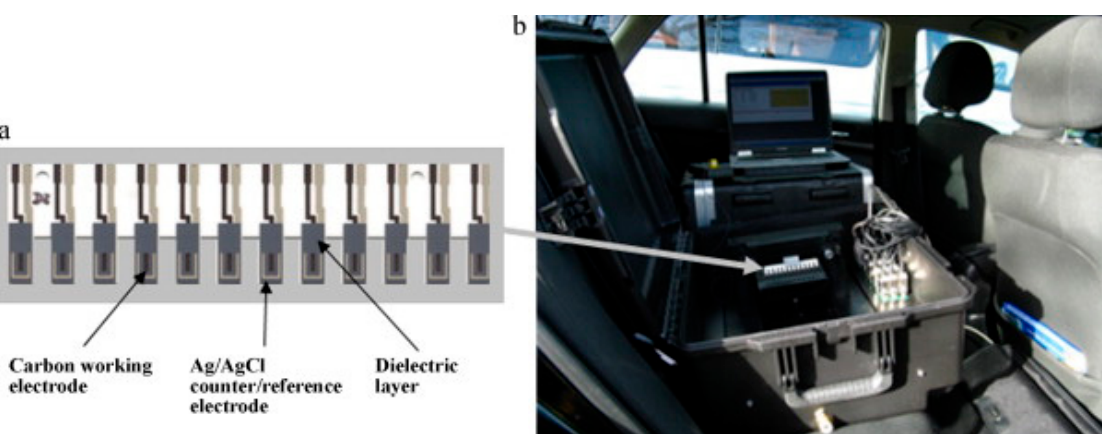
Figure 8. ( a ) Electrode array comprising 12 screen-printed carbon electrodes modified with cobalt phthalocyanine (CoPC) and an Ag/AgCl counter/reference electrode printed on an alumina substrate; ( b ) array in the prototype biosensor system operating in the field powered from a car battery via the lighter socket. Reproduced with permission [81].